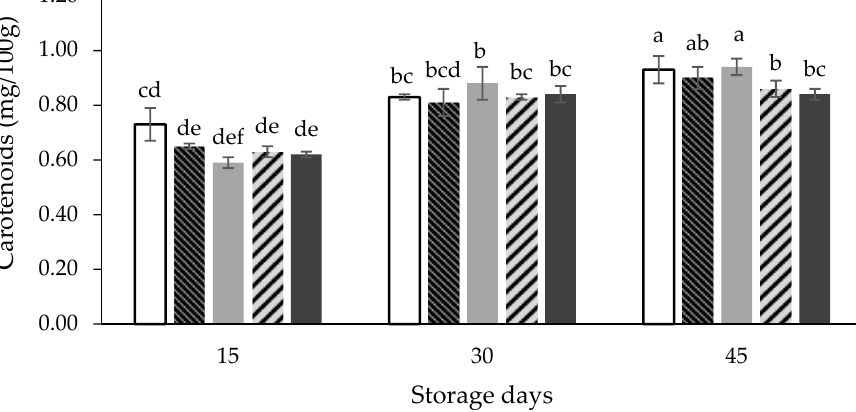
Figure 6. Effects of chitosan, phenylalanine, and chitosan-coated phenylalanine nanoparticles treatments on the carotenoids content of persimmon fruit during storage at 4 °C for 15, 30, and 45 days. Each value represents the mean ± standard errors of three replications. Different letters indicate statistical differences using Duncan’s multiple range tests at P < 0.05 level.